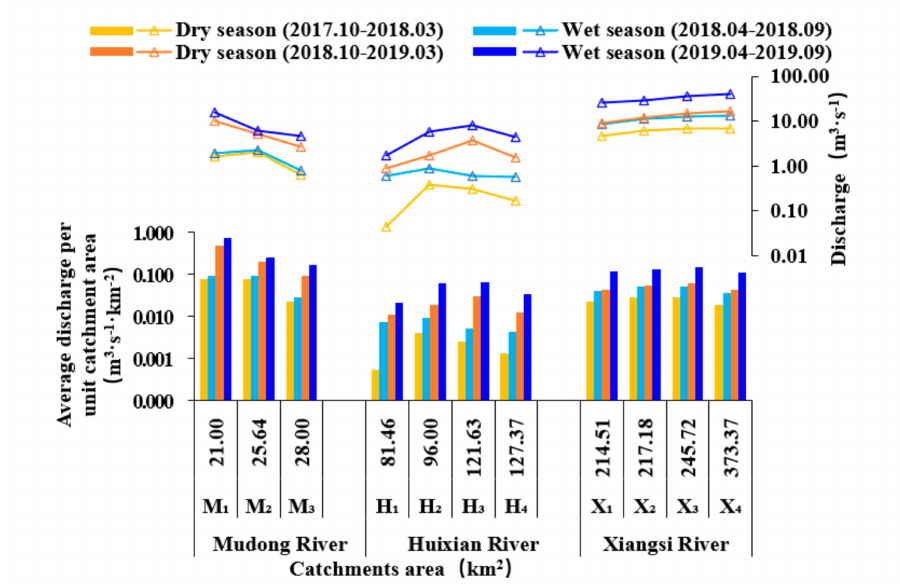
Figure 3. The mean discharge (lines) and discharge per unit catchment area (bars) at the eleven monitoring sections in the dry and wet